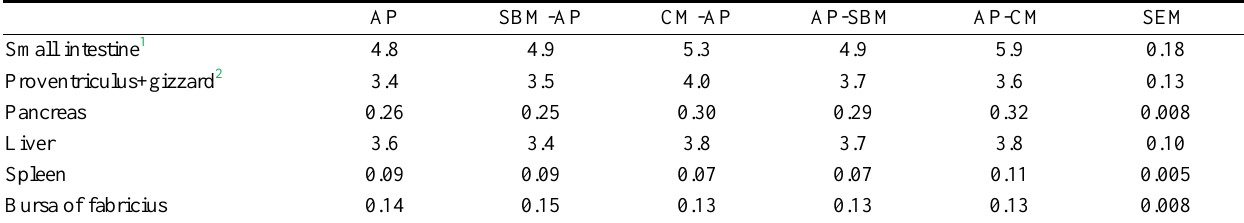
Table 4. Relative weight of visceral organs (g/100 g of body weight) of broiler chickens at different feeding plans at 21 days